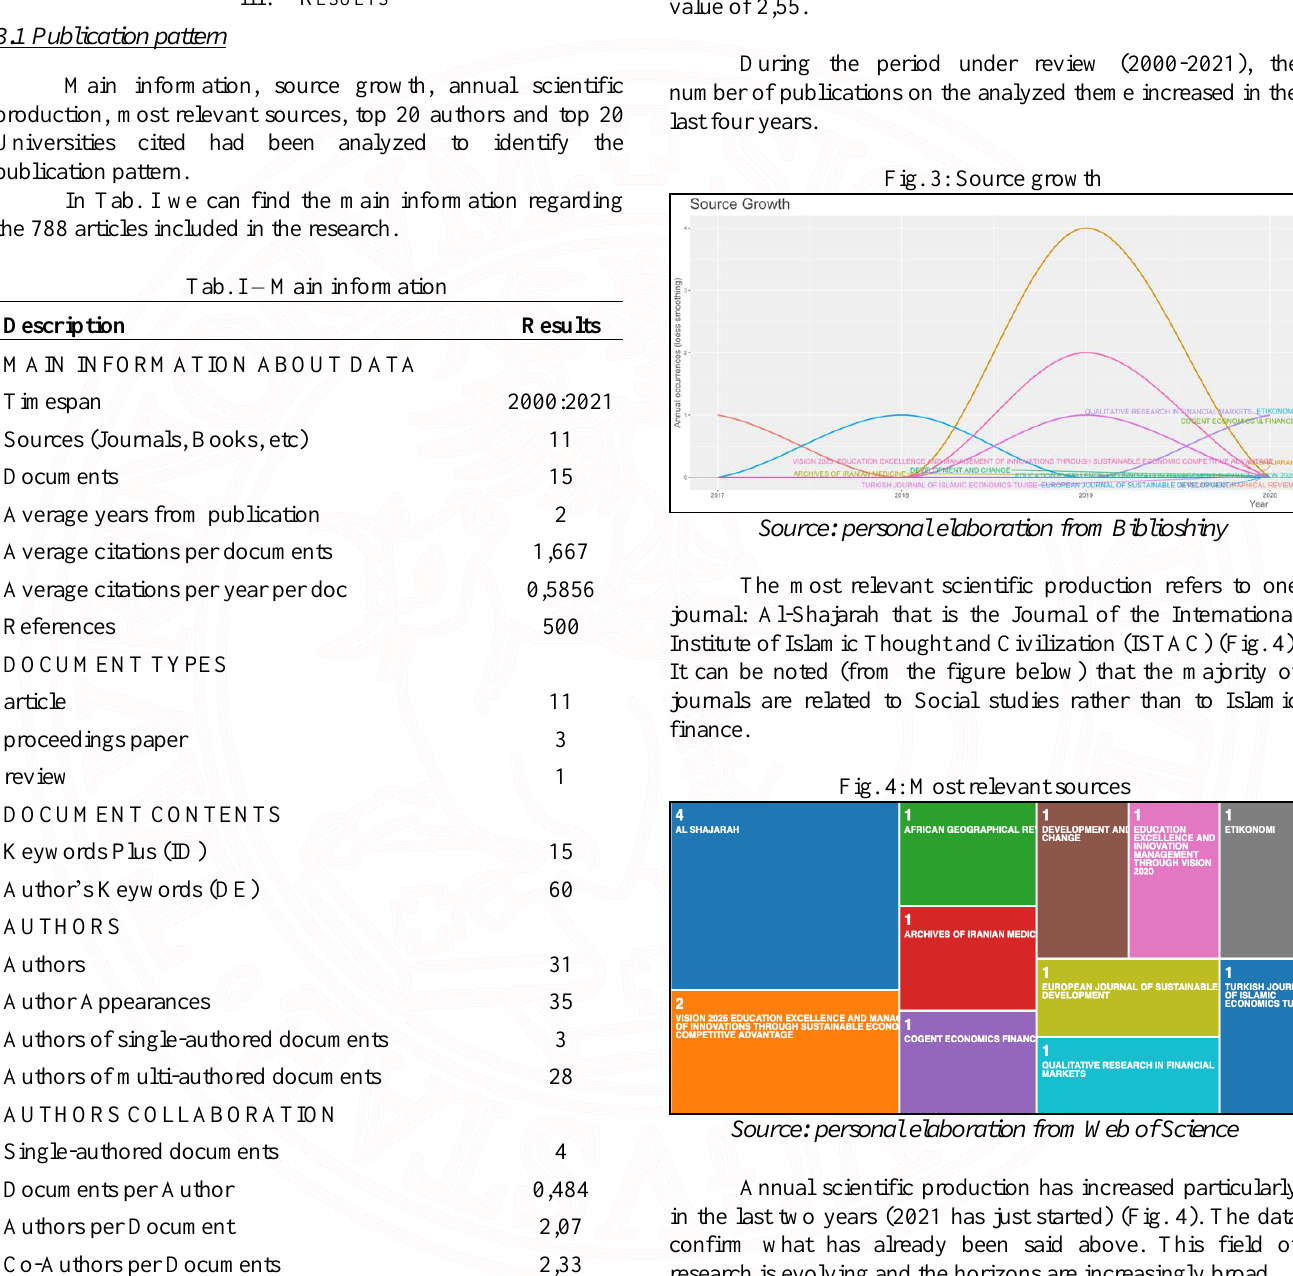
Source: personal elaboration from Web of